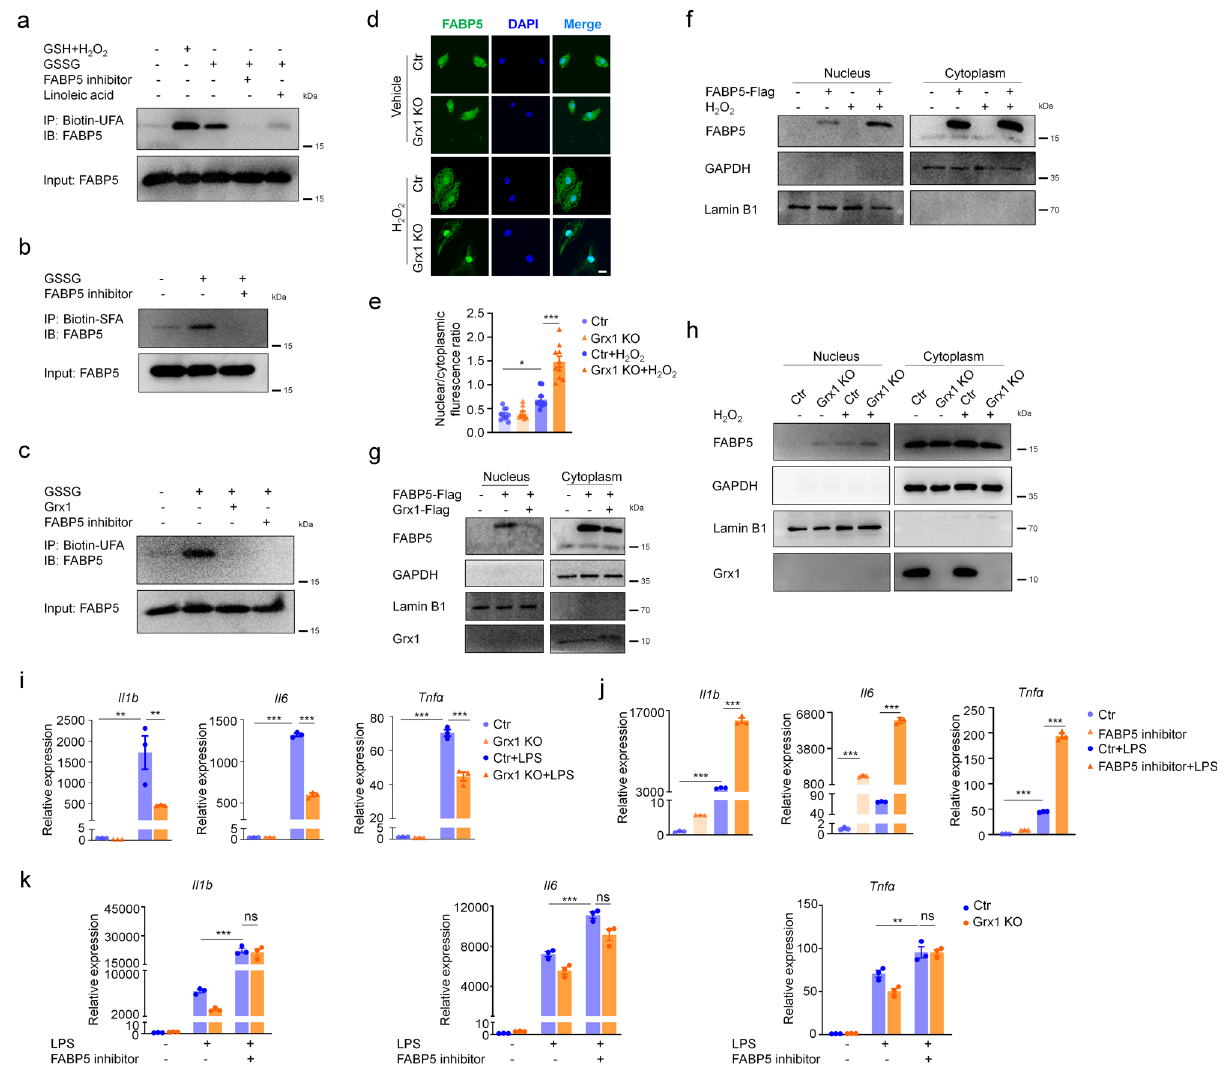
Fig. 5 S-glutathionylation promotes the nuclear translocation and fatty acid binding of FABP5. a – c Immunoblot analysis of FABP5 binding to ULCFA ( a ), SLCFA ( b ) or ULCFA with Grx1 treatment ( c ). Puri fi ed recombinant FABP5 protein was incubated with GSH plus H 2 O 2 or GSSG for 15 min, then mixed with Biotin-ULCFA or Biotin-SLCFA in the absence or presence of BMS309403 or linoleic acid or Grx1. FABP5 interacted with the Biotin-ULCFA or Biotin-SLCFA was captured using streptavidin magnetic beads. d Immuno fl uorescence staining of BMDMs after exposure to H 2 O 2 (200 μ M) for 30 min (green, FABP5; blue, DAPI; scale bars, 10 μ m). e Quantitative analysis of the ratio of nuclear/cytoplasmic fl uorescence intensity in BMDMs as in ( d ), n = 10 in each group, P = 0.0172, P (ctr vs. ctr H2O2) (ctr H2O2 vs. Grx1 KO H2O2) <0.0001. f Immunoblot analysis of cytoplasmic and nuclear FABP5 in COS-7 cells. COS-7 cells were transfected with pXJ40-3xFlag vector or pXJ40-3xFlag-FABP5 followed by exposure to H 2 O 2 (200 μ M) for 1 h. Lamin B1 (nuclear fraction) and GAPDH (cytoplasmic fraction) are loading controls. g Immunoblots with antibodies against the indicated proteins in nuclear and cytoplasmic fractions from COS-7 cells co-transfected with pXJ40-3xFlag-FABP5 (or vector) and pcDNA3.1-3xFlag-Grx1 (or vector) for 24 h, then exposed to H 2 O 2 (200 μ M) for 1 h. h Immunoblots against the indicated proteins of cytoplasmic and nuclear extracts from BMDMs exposed to H 2 O 2 (200 μ M) for 1 h. i mRNA expression of Il1b , Il6 , and Tnf α in BMDMs from mice stimulated with LPS (100 ng/mL) for 4 h, as evaluated by qPCR, n = 3 in each group, P = 0.0013, ( Il1b , Ctr vs. Ctr + LPS) P = 0.0091, *** P < 0.0001. j mRNA levels of Il1b , Il6 , and Tnf α in BMDMs pre-treated with an FABP5 inhibitor (SBFI26, 100 μ M) ( Il1b , Ctr + LPS vs. Grx1 KO + LPS) for 2 h and stimulated with LPS (100 ng/mL) for 4 h, as determined by qPCR, n = 3 in each group, *** P < 0.0001. k mRNA levels of Il1b , Il6 , and Tnf α in BMDMs after treated with SBFI26 (100 μ M) for 2 h and stimulation with LPS (100 ng/mL) for 4 h, as evaluated by qPCR, n = 3 in each group, P P P = 0.0046. All samples were biologically ( Il1b , Ctr + LPS vs. Ctr + LPS + inhibitor) < 0.0001, ( Il16 , Ctr + LPS vs. Ctr + LPS + inhibitor) < 0.0001, ( Tnf α , Ctr + LPS vs. Ctr + LPS + inhibitor) independent and three or more independent experiments were performed. All quantitative data are shown as mean ± SEM and analyzed with a 95% con fi dence interval. One-way ANOVA followed by Tukey ’ s post-hoc test for (e, i-k). * P < 0.05, ** P < 0.01, *** P < 0.001, ns = no signi fi cance. Source data are provided as a Source Data fi